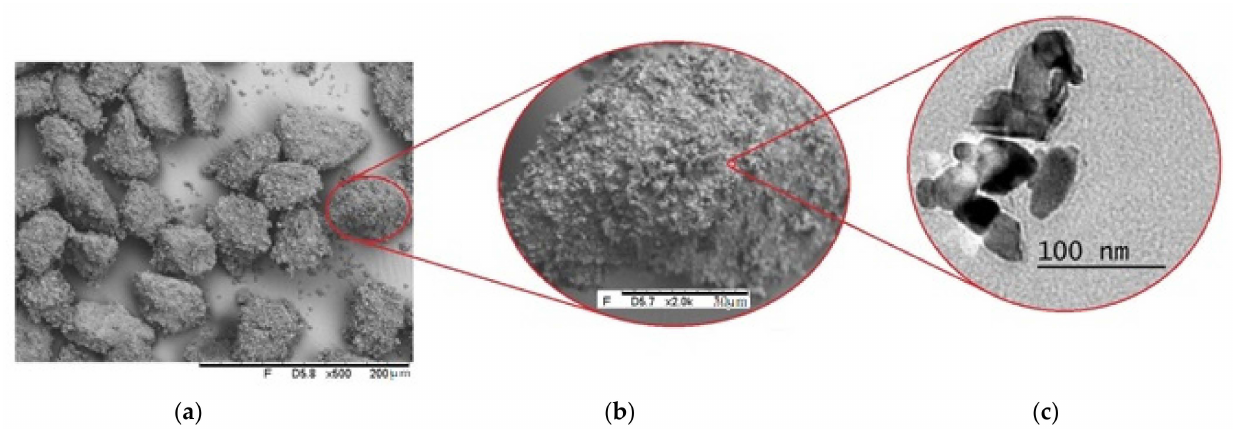
Figure 4. SEM images of the Cr 3 C 2 -25NiCr milled particles. ( a ) Sets of milled particles agglomeration. ( b ) Agglomerated milled particles in more detail. ( c ) TEM images showing the irregular shape of single-milled